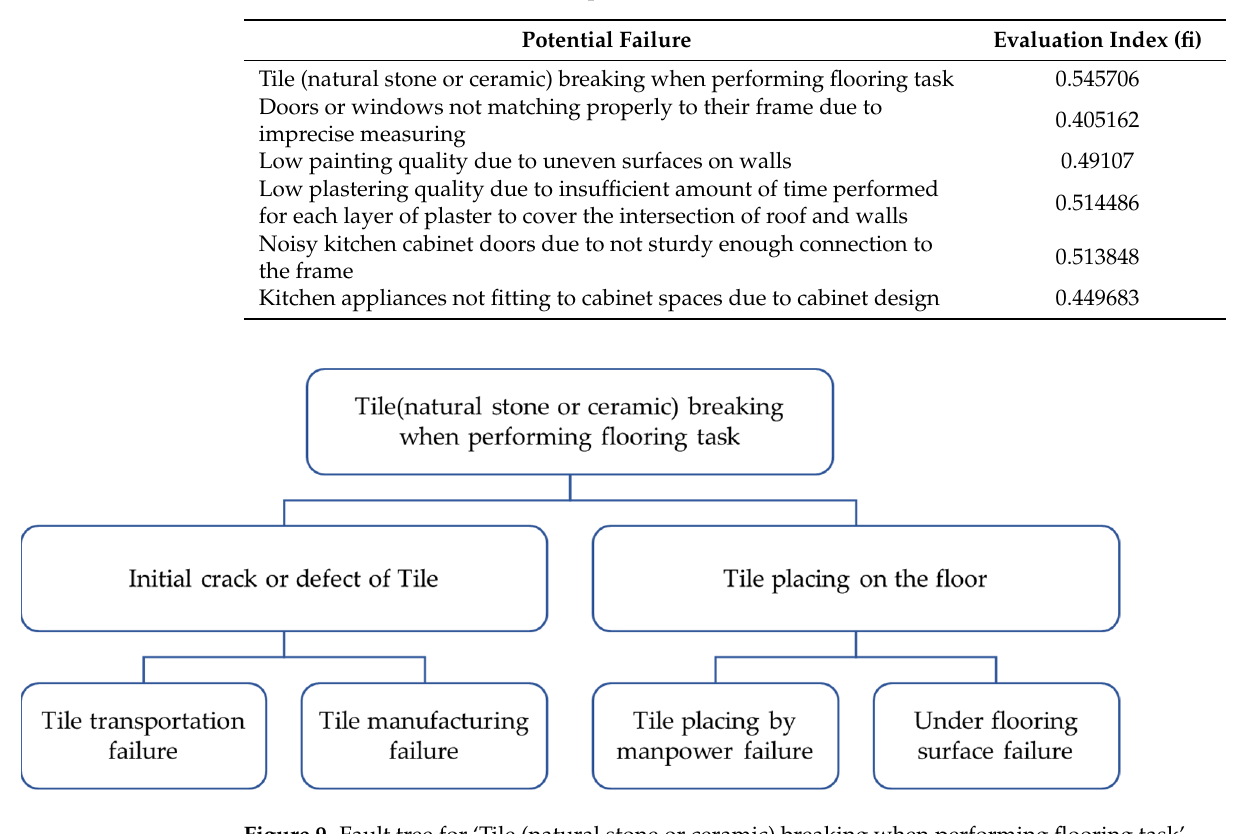
Table 8. Weight of criteria related to identifying the most critical failure mode.